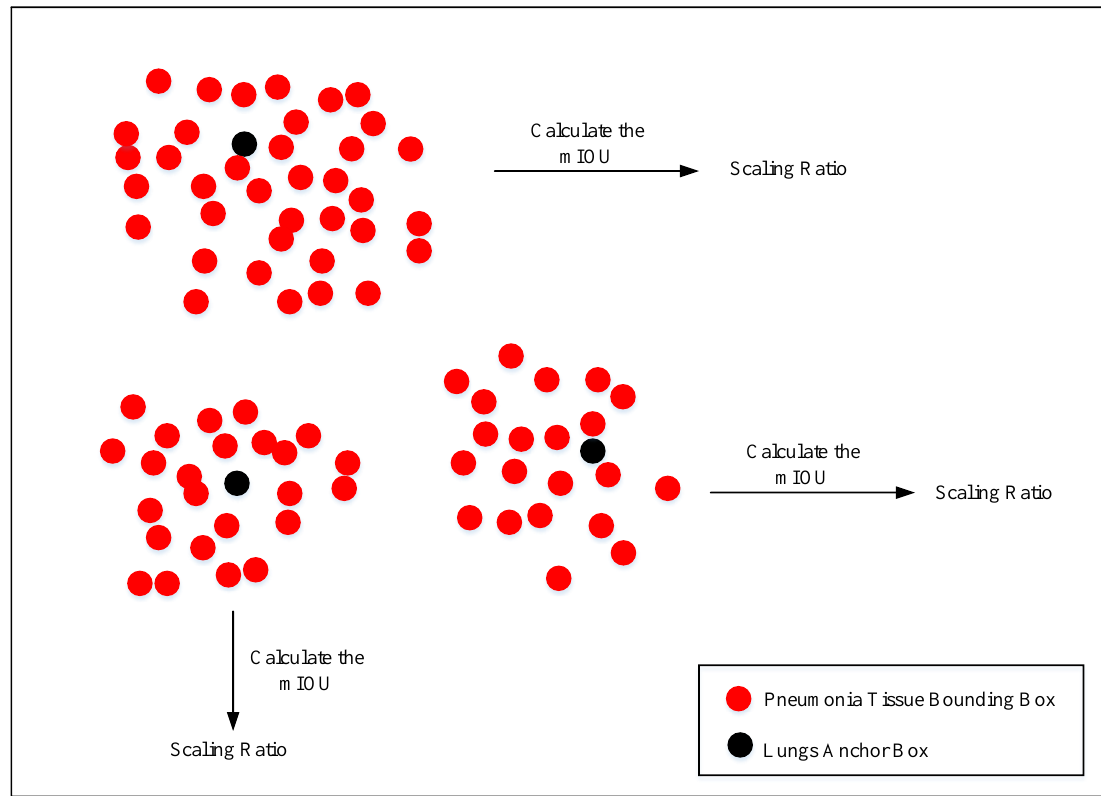
Figure 5. Schematic of scaling ratio generation. The black dots represent the cluster center; mIOU is the average value of the IOU of the black points and all the red points in each cluster, and this value is taken as the scaling ratio.